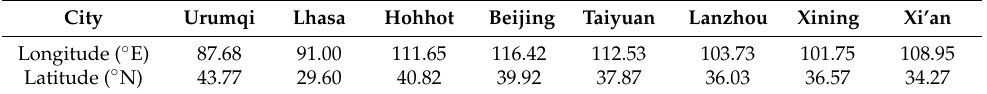
Table 1. The urban start location for